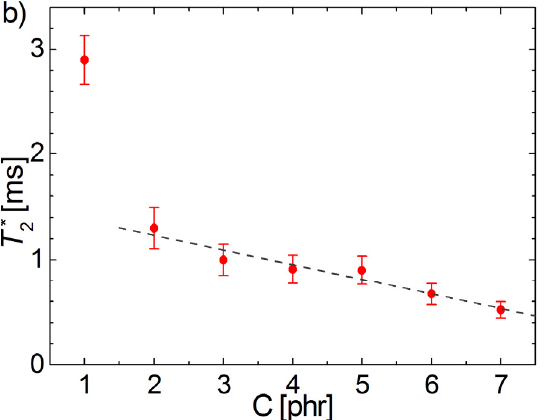
Figure 10. ( a ) The inverse Laplace-like spectra (Equation (18)) which show the distributions of residual dipolar couplings ω D /2 π for the series of cross-linked natural rubber naturally aged for six years. ( b ) The effective transverse relaxation time as a function of cross-link density obtained from the best fit of the normalized 1 H DQ build-up curves using the inverse Laplace-like transformation. The dashed line represents the best liner fit of the data for the samples NR2 to NR7.